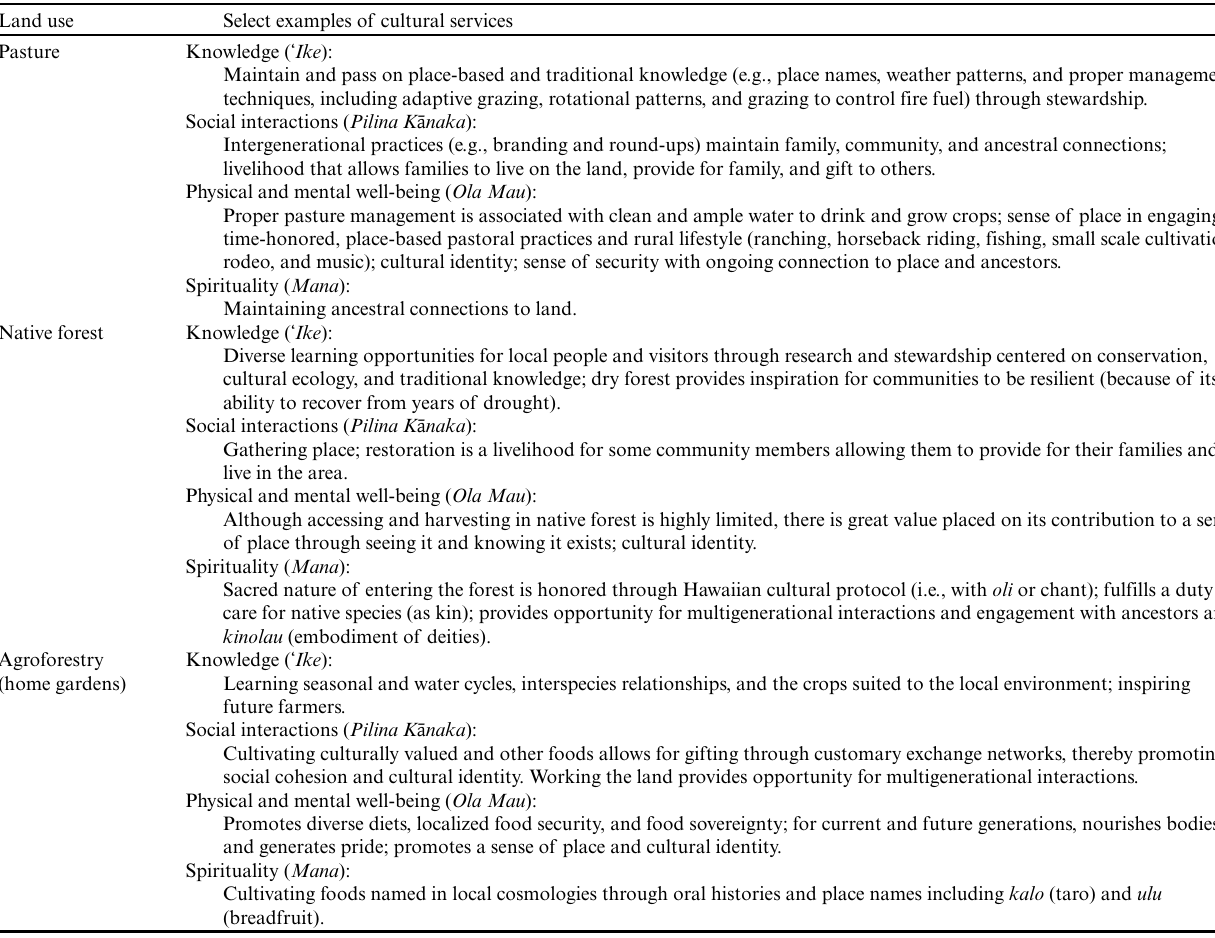
Table 1. Examples of cultural services discussed by workshop participants associated with land-use types (categories based on Hawai ʻ i CES framework (Pascua et al.